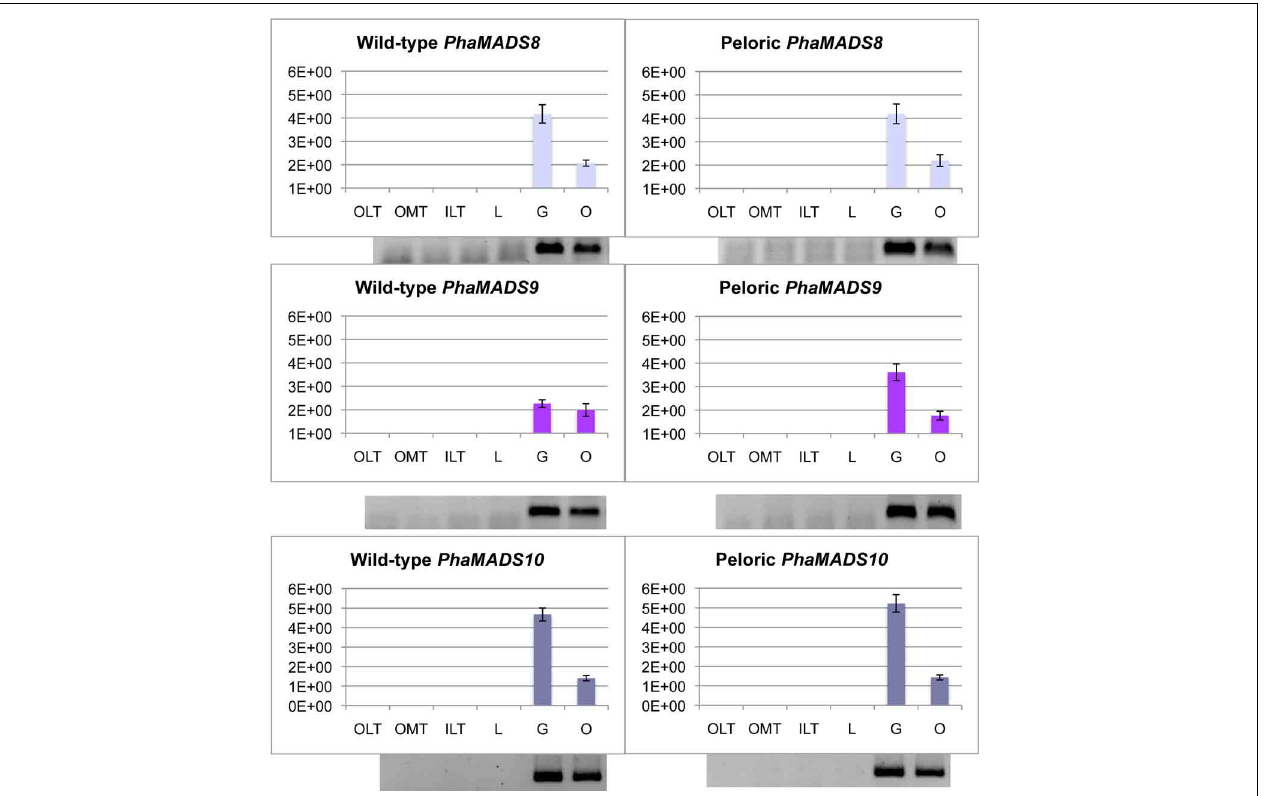
FIGURE 7 | Normalized expression of orchid AGAMOUS - and SEEDSTICK -like genes. Expression of PhaMADS8 , PhaMADS9 and PhaMADS10 in six flower organs of wild-type and peloric Phalaenopsis hybrid “Athens.” Replicates, normalization, graphics and abbreviations are as described in Figure 5